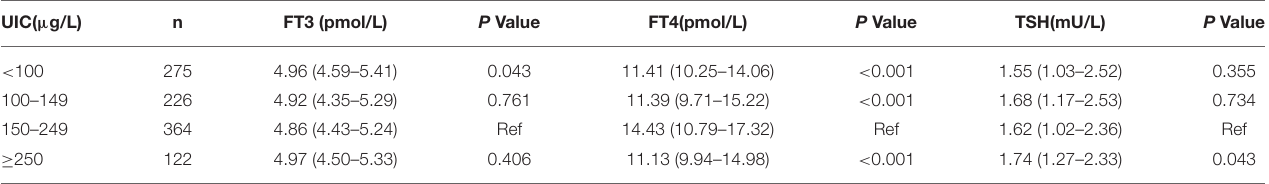
TABLE 2 | Serum concentrations of FT3, FT4 and TSH in the first trimester among women by UIC group.